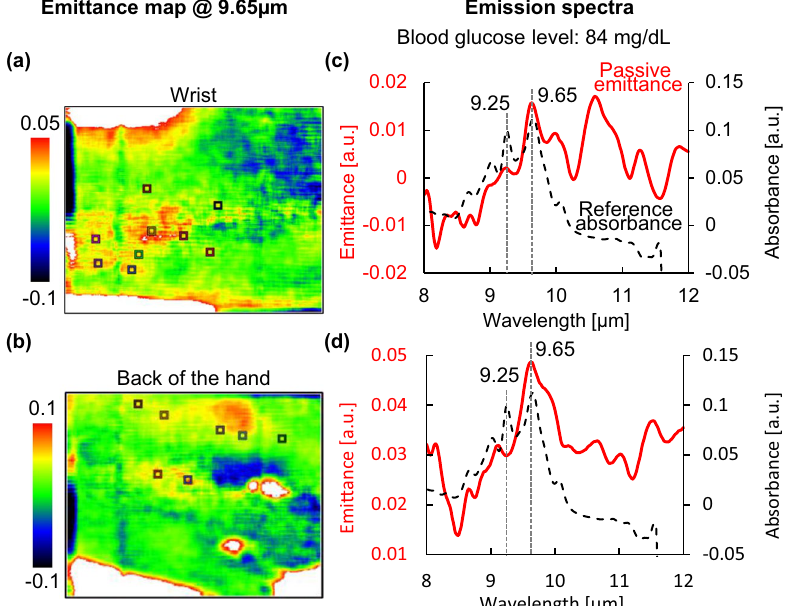
Figure 2. Results of mid-infrared passive spectroscopic imaging using subject A’s wrist and back of the hand as measurement sites. (a) Spectral emission map at 9.65 µm of the wrist. (b) Spectral emission map at 9.65 µm of the back of the hand. (c) Emission spectrum of the wrist. (d) Emission spectrum of the back of the hand. The ranges of the color maps in ( a,b ) were adjusted manually. The red solid line in ( c,d ) shows the emission spectrum obtained using the proposed method, and the black dashed line shows the absorption spectrum of glucose solution measured using FTIR.